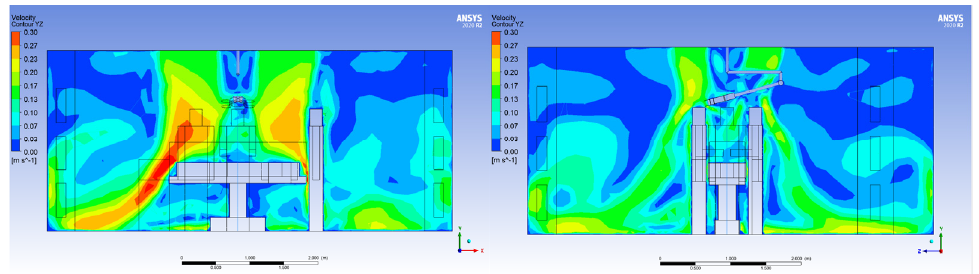
Figure 7. Air velocity profiles for variant 1 on the XY plane ( left ) and YZ ( right ).